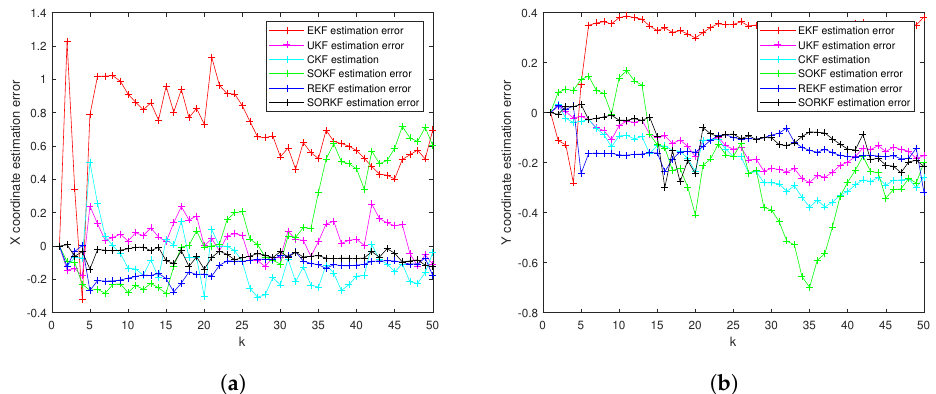
Figure 9. R3 estimation error of multi-robot in fixed formation. ( a ) X-Coordinate estimation error; ( b ) Y-Coordinate estimation error.